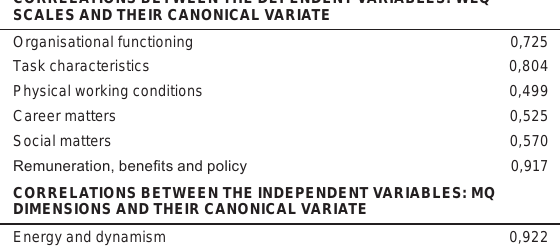
Table 4 Canonical structure for the first canonical function between the MQ dimensions and the WLQ scales